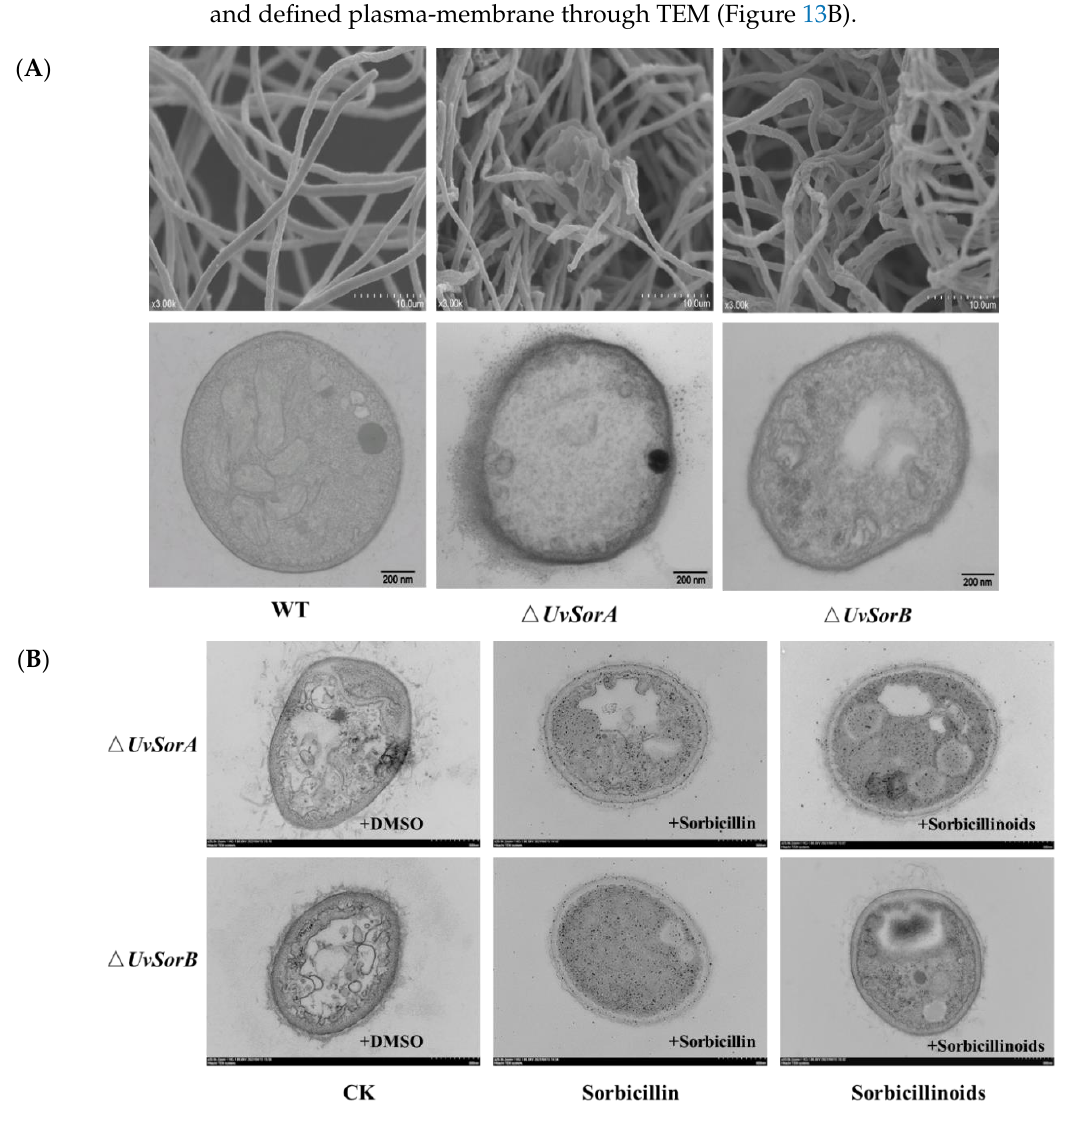
Figure 13. Microscopic and submicroscopic alterations of mycelia structures observed and analyzed by SEM and TEM. ( A ) The WT, Δ UvSorA , and Δ UvSorB mutants were grown on PSA for 10 days at 28 °C. Up column: scale bar = 10 µm, down column: scale bar = 200 nm; ( B ) Ultrastructural analyses of the cell wall integrity of feeding experiment. Sorbicillin and crude sorbicillinoid extract were dissolved in 10% DMSO, scale bar = 500 nm.